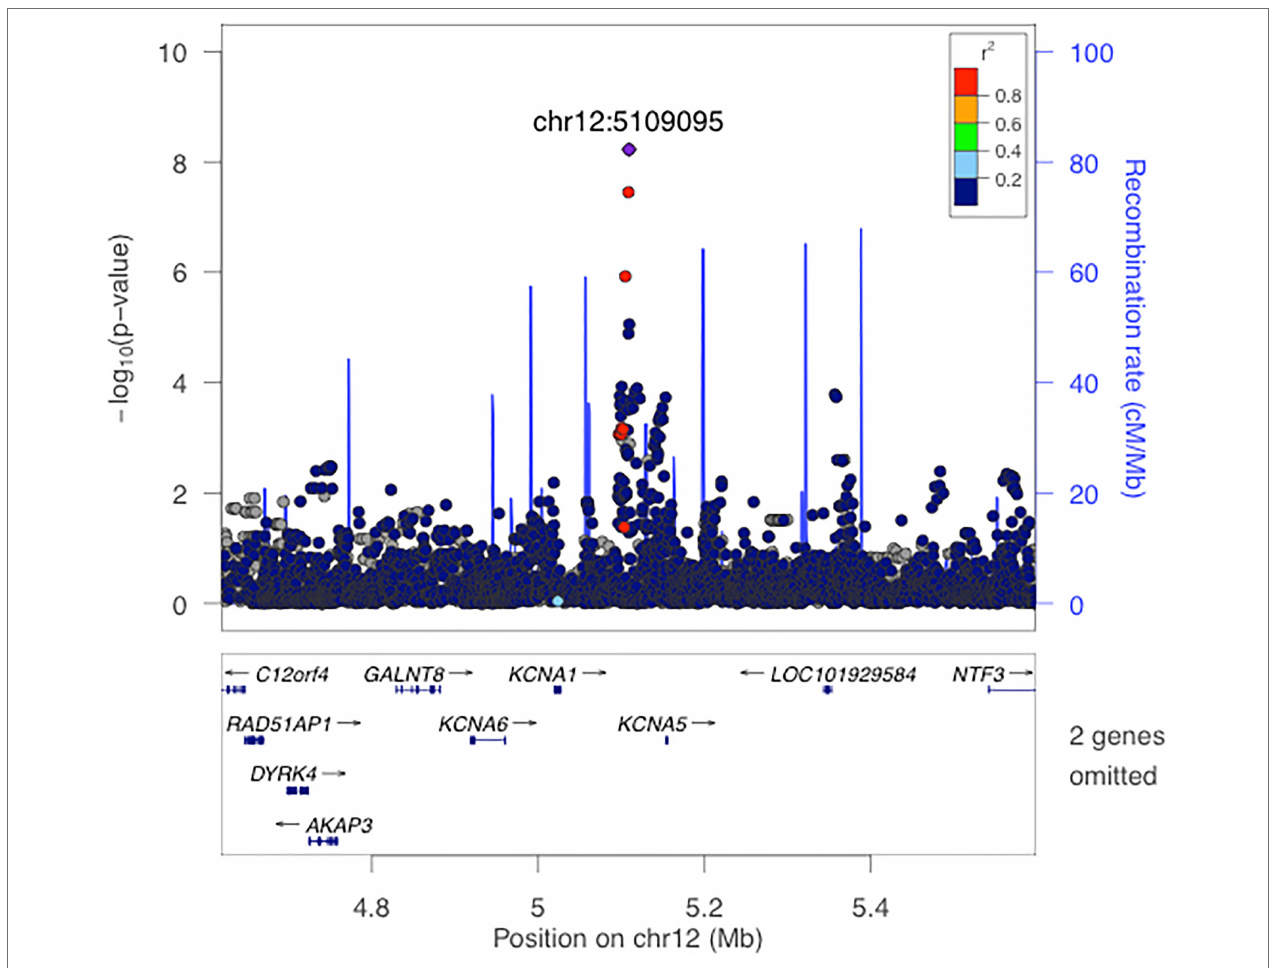
FIGURE 2 | Local association plot for